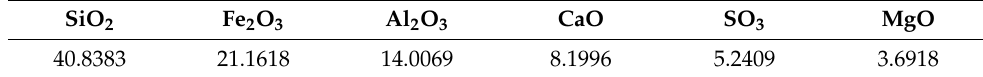
Table 2. Mass fraction of main chemical components of tailings (%).